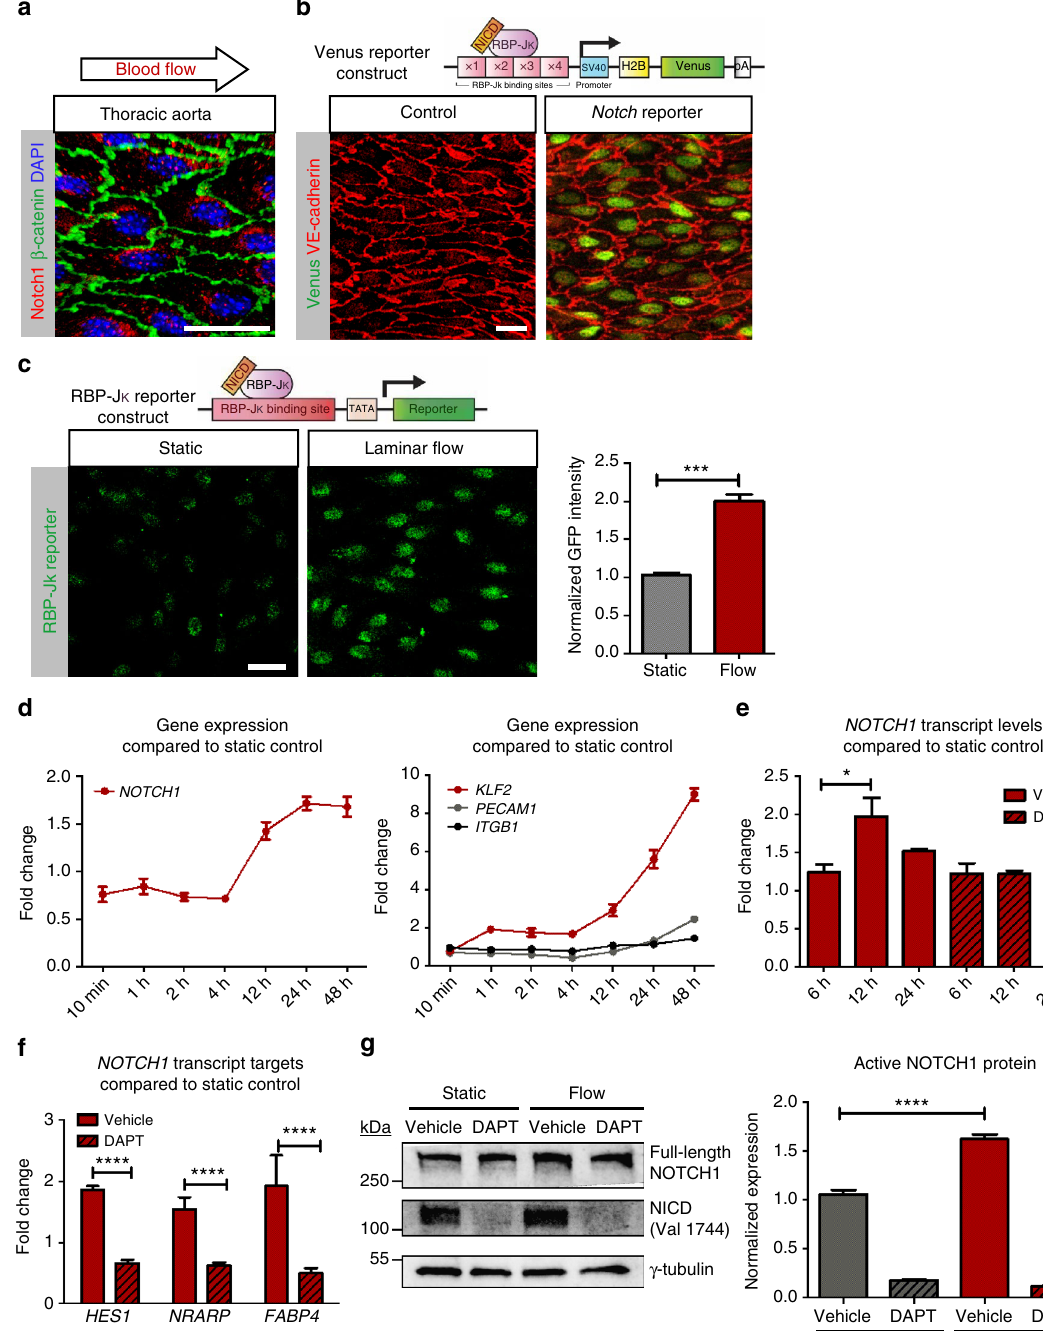
Fig. 1 Notch1 is activated by shear stress in vitro. a En face confocal imaging of wildtype (C57BL/6) adult mouse thoracic endothelium shows Notch1 (red). Staining was done in 20 mice of different strains with identical results, scale bar = 20 µ m. b En face imaging of Venus Notch reporter mouse (RBP-Jk:H2B- Venus transgenic) compared to control aorta imaged using identical settings. Note that levels of reporter vary amongst cells indicating distinct degrees of activation in the intima at a given time. Scale bar = 20 µ m. c HAECs transfected with GFP-RBP-Jk reporter showed a two-fold increase in GFP signal intensity under fl ow (20 dynes cm − 2 ) compared to static control at 24 h (plotted is average GFP intensity ± SEM of ~120 cells per condition, from three biological replicates). T- test, ***P < 0.001. Scale bar = 20 µ m. d Onset of fl ow (from 10 min to 48 h) increases NOTCH1 mRNA after 4 h for HAECs. Transcript levels of KLF2 , PECAM1 , and ITGB1 were also pro fi led over time and compared to static controls. Data shown include mean ± SEM, n = 4 biological replicates. e NOTCH1 transcript levels assessed by NanoString chip technology. HAECs were subjected to laminar shear stress for 6, 12, and 24 h with γ -secretase inhibitor DAPT or vehicle and compared to vehicle treated static controls. Graph bars represent mean ± SEM, n = 4 biological replicates, statistical signi fi cance for 6 h and 12 h: Wilcoxon rank-sum test, P = 0.0236. f Flow response of NOTCH1-target genes HES1 , NRARP , and FABP4 was determined in HAECs after 12 h of laminar fl ow while treated with DAPT or vehicle and compared to vehicle-treated static controls. Graph bars represent mean ± SEM, n = 5 biological replicates. T- test, ***P < 0.001. g Endothelial monolayers were fl ow-conditioned for 24 h in the presence of DAPT or vehicle and protein lysates were analyzed by immunoblot to determine NICD expression levels ( n = 5 biological replicates, ****P < 0.0001 by t-